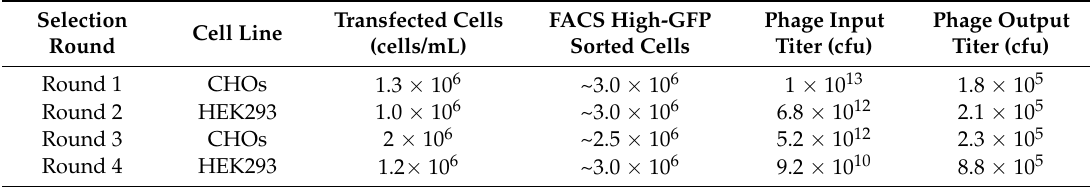
Table 1. Cell-based biopanning selection of canine CD117-specific scFv-phage binders. Phage titer expressed as colony forming units